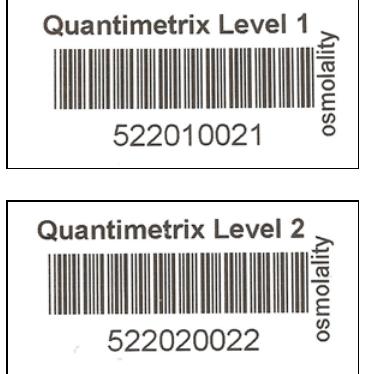
Figure 12-3. Example of Quantimetrix bar-code